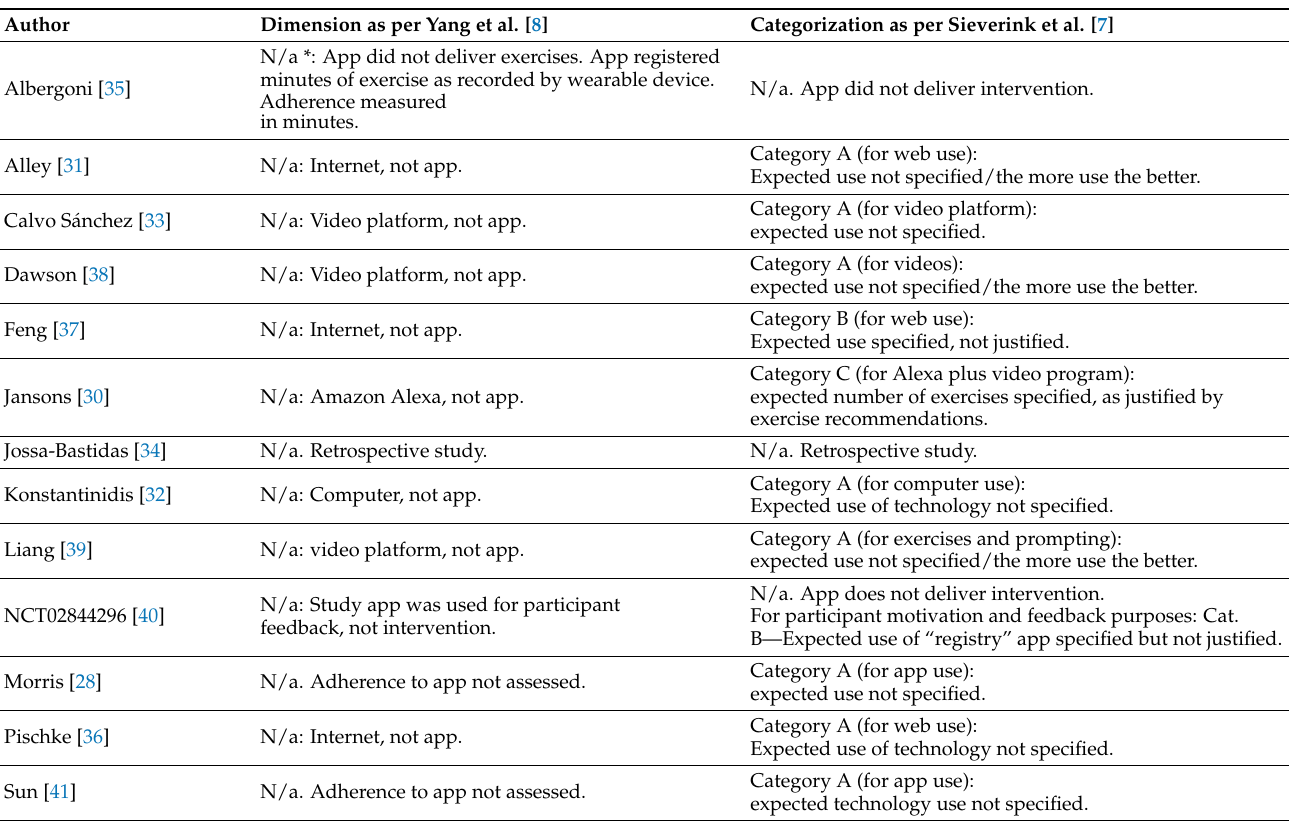
Table 2. Operationalization of reviewed papers as per Yang et al. and Sieverink et al.’s classifications of adherence to eHealth